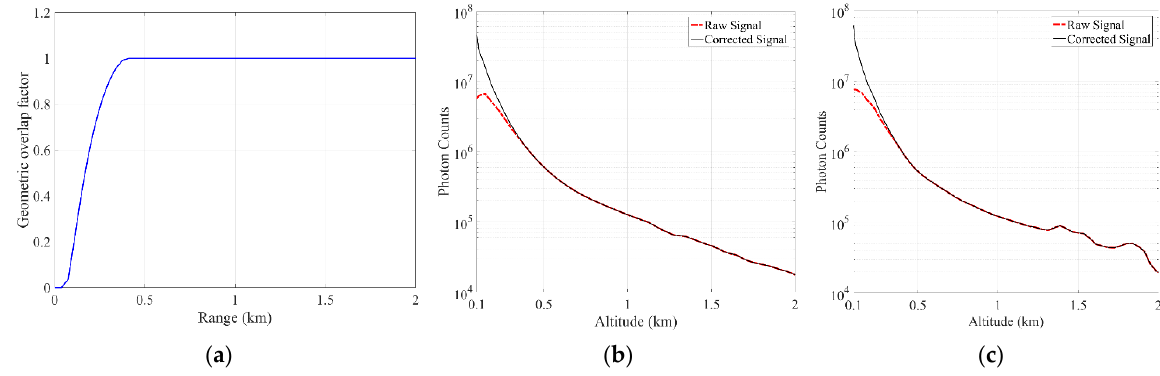
Figure 4. ( a ) The profile of geometric overlap factor change with range; ( b ) The signal at 0:30 on 24 June 2019, corrected by geometric overlap factor; ( c ) The signal at 10:30 on 30 December 2019, corrected by geometric overlap factor.